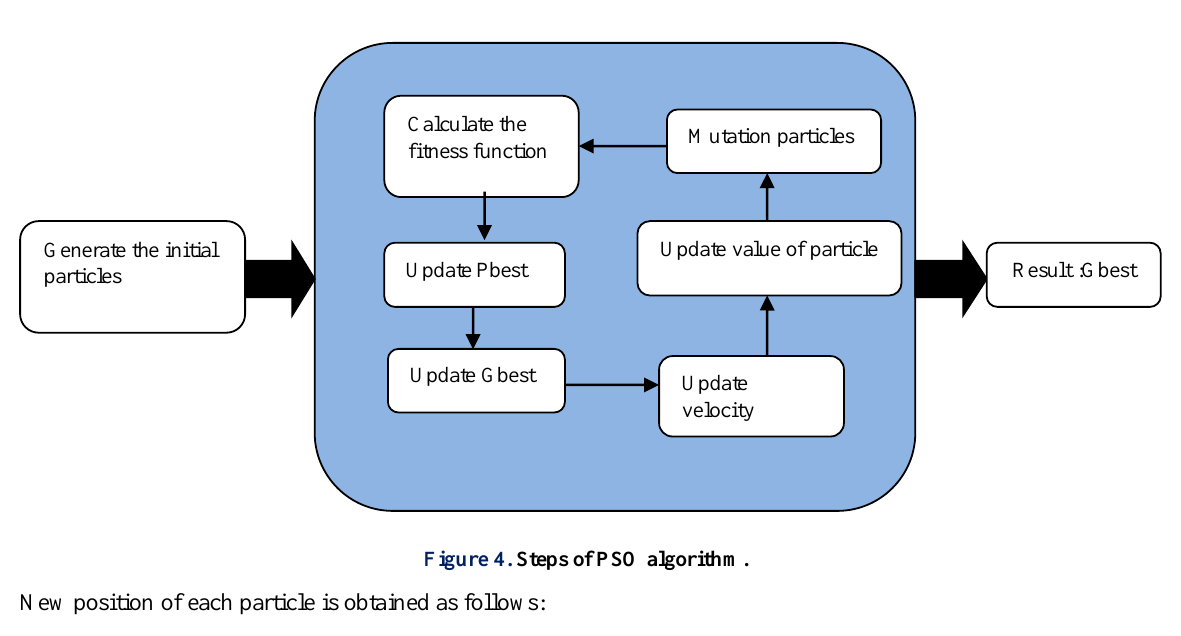
Figure 4. Steps of PSO